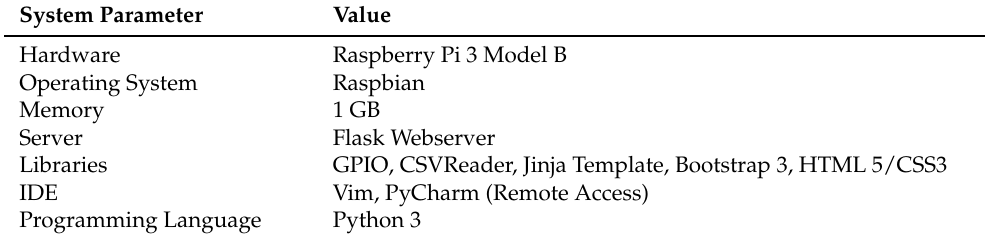
Table 3. Specification of implementation environment of the Raspberry Pi embedded